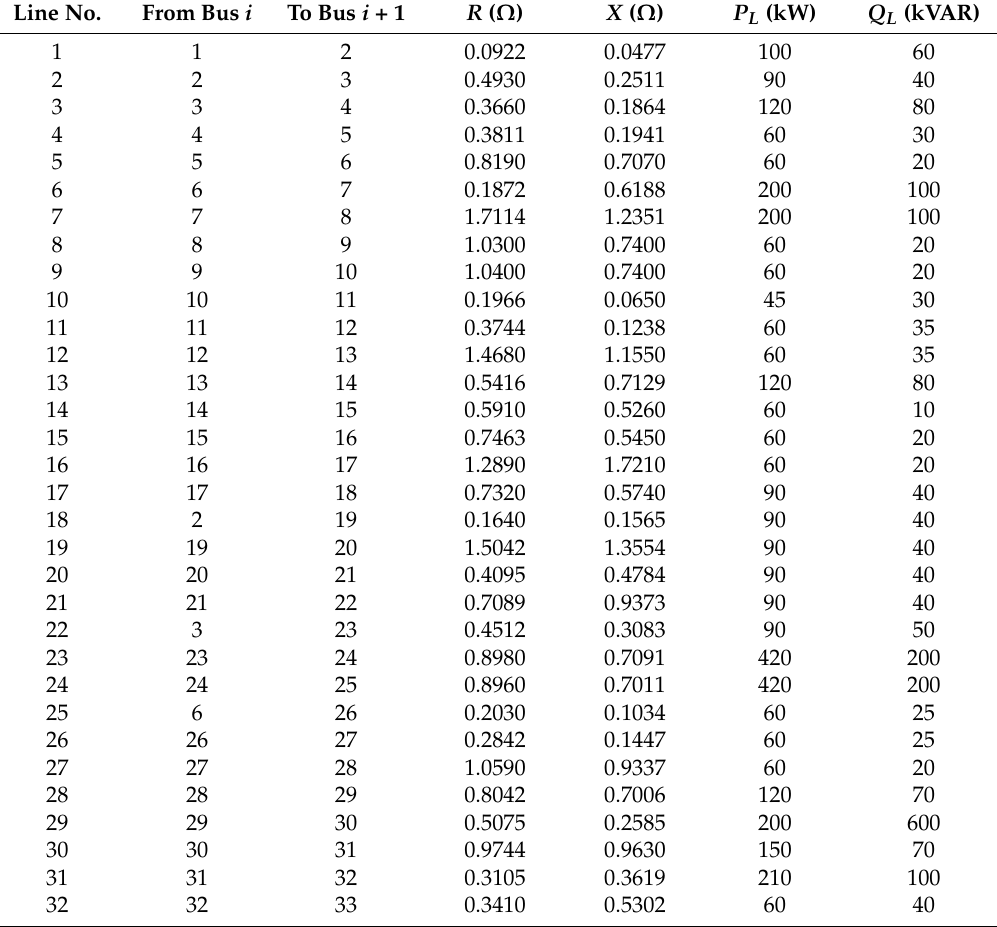
Table A2. 33-bus test system